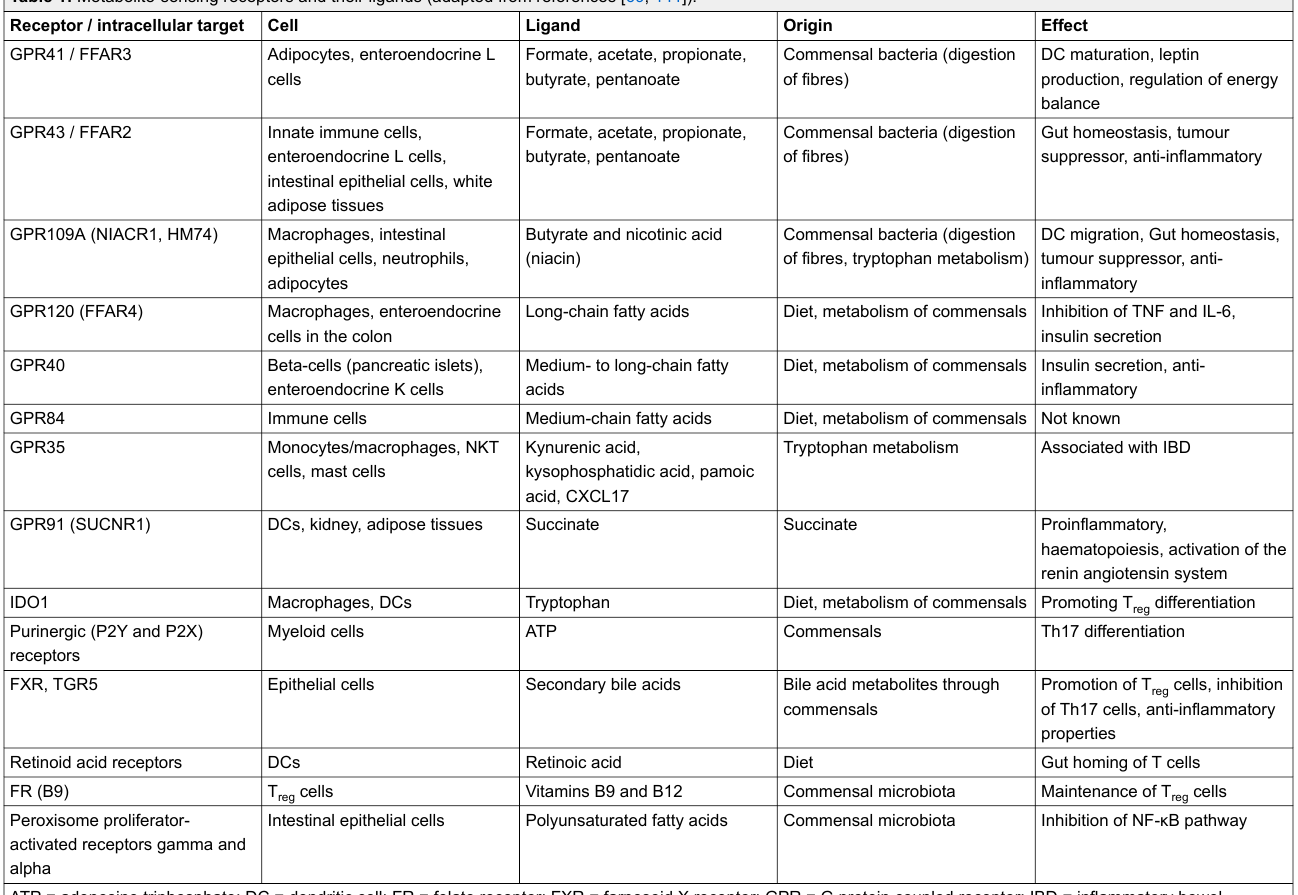
Table 1: Metabolite-sensing receptors and their ligands (adapted from references [69, 141]). Receptor / intracellular target Cell